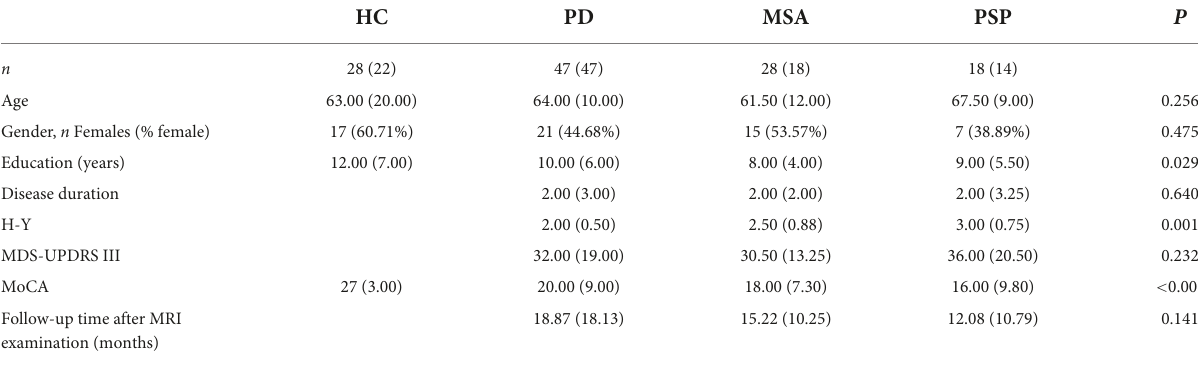
TABLE 1 Demographic and clinical